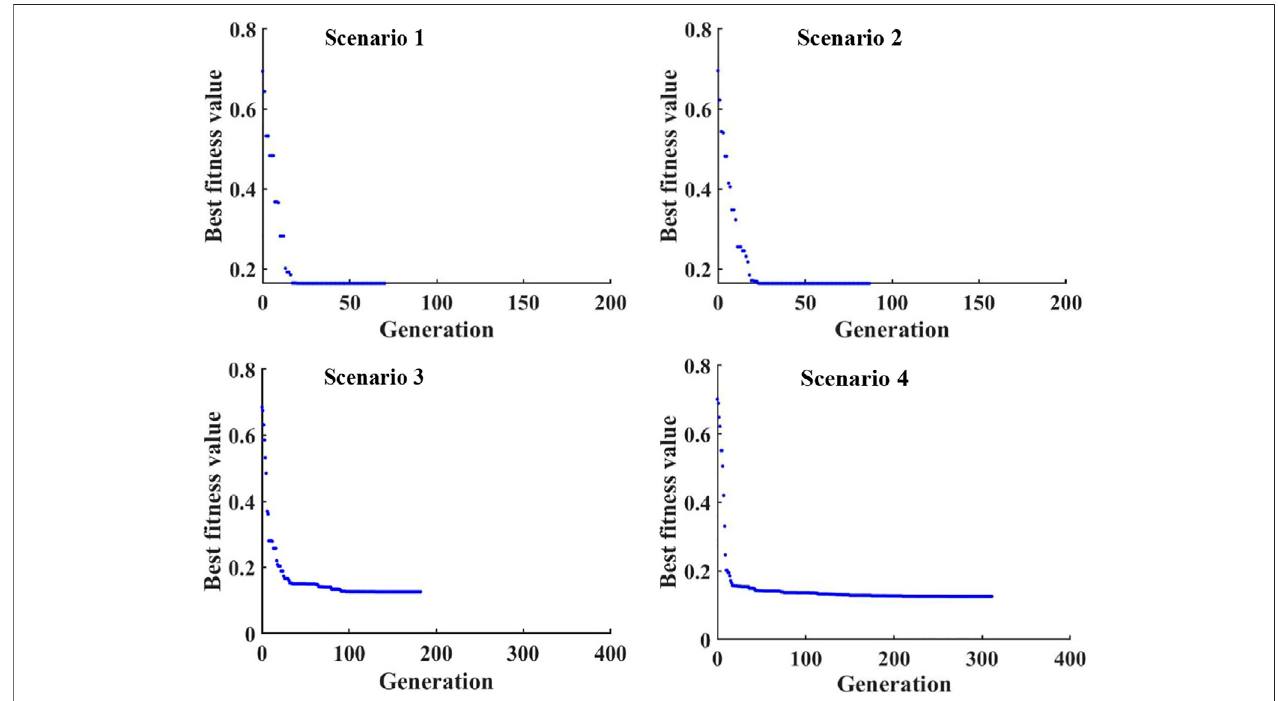
FIGURE3| Changeprogressofbest fi tnessvaluewithevolutionarygenerationsforGAoptimizationunderdifferentinversionscenarios:Scenario1:onlyestimating source strength (Q 0 ); (b) Scenario 2: estimating source strength (Q 0 ) and release height (z 0 ); Scenario 3: estimating both source strength (Q 0 ) and horizontal location (x 0 ,